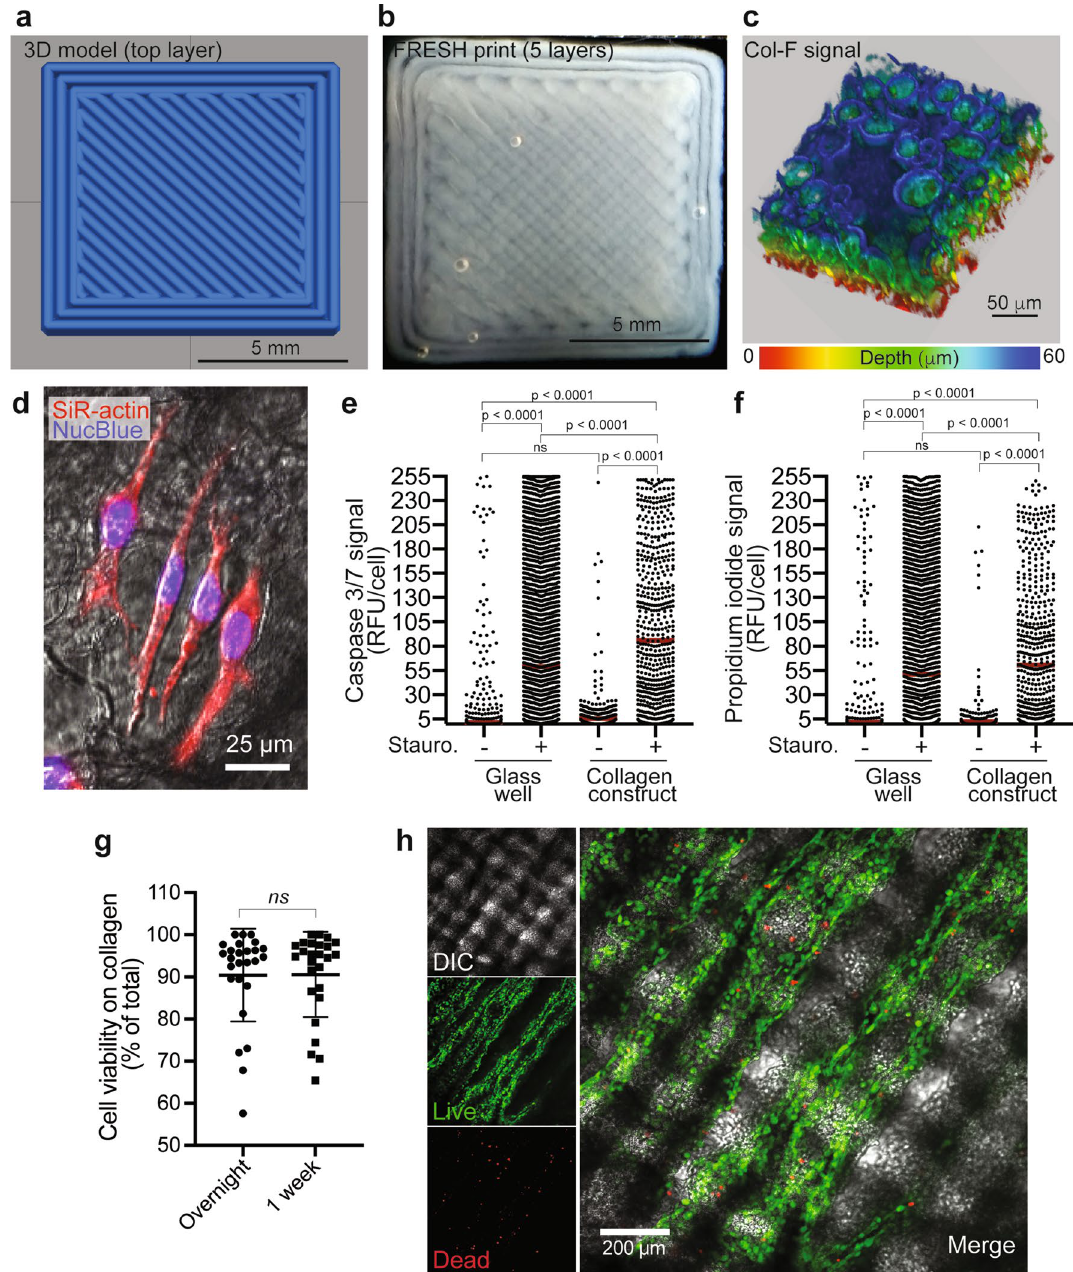
Figure 3. FRESH bioprinting using the open source bioprinter. ( a ) Design of the construct to be printed using FRESH methodology, and ( b ) actual FRESH bioprinted construct. ( c ) 3D rendering of a Col-F stained bioprinted collagen construct based on imaging by confocal microscopy. ( d ) Example of MDA-MB-231 breast cancer cells seeded onto a bioprinted collagen construct post printing. The cells were stained with SiR-actin and NucBlue to visualize the actin cytoskeleton and cell nuclei respectively. The cells were shown to attach and adopt normal cell morphologies a few hours after cell seeding. The relative level of active apoptosis ( e ) as measured by Caspase 3/7 activity, and relative occurrence of dead cells ( f ) as measured by propidium iodide signal in cells grown in glass-bottomed wells or on FRESH bioprinted collagen constructs, in the presence or absence of the apoptosis-inducing toxin staurosporine (10 μM for 5 h) are shown. ( g ) Analysis of cell viability as assessed by fluorescein diacetate (live) and propidium iodide (dead) staining of MDA-MB-231 breast cancer cells after overnight culture (~ 20 h) on bioprinted collage constructs, and 1 week later. ( h ) Example of fluorescein diacetate (live cells) and propidium iodide (dead cells) staining of MDA-MB-231 breast cancer cells distributed on the bioprinted collagen constructs following 1 week of culture. Differential interference contrast imaging (DIC) reveals the crisscross patterning of the